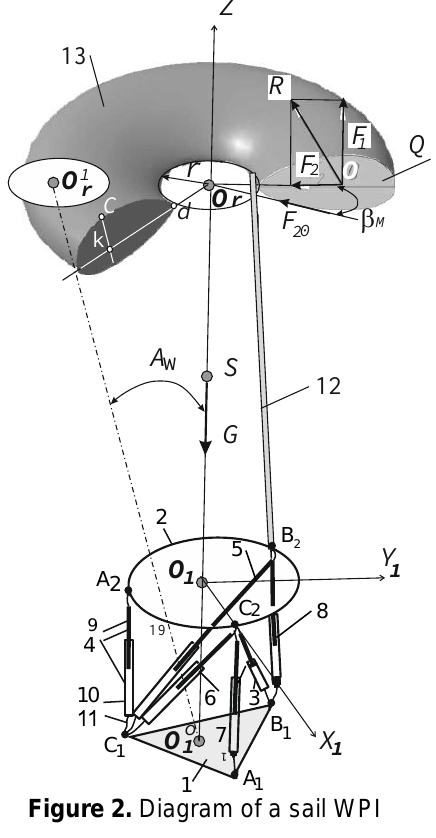
Figure 2. Diagram of a sail